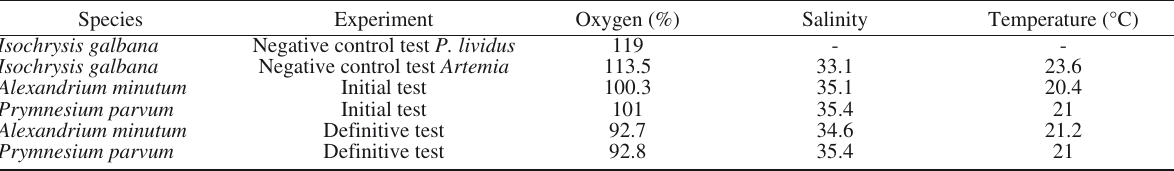
Table 2. – Physico-chemical parameters measured in flasks of the different microalgae cultures.